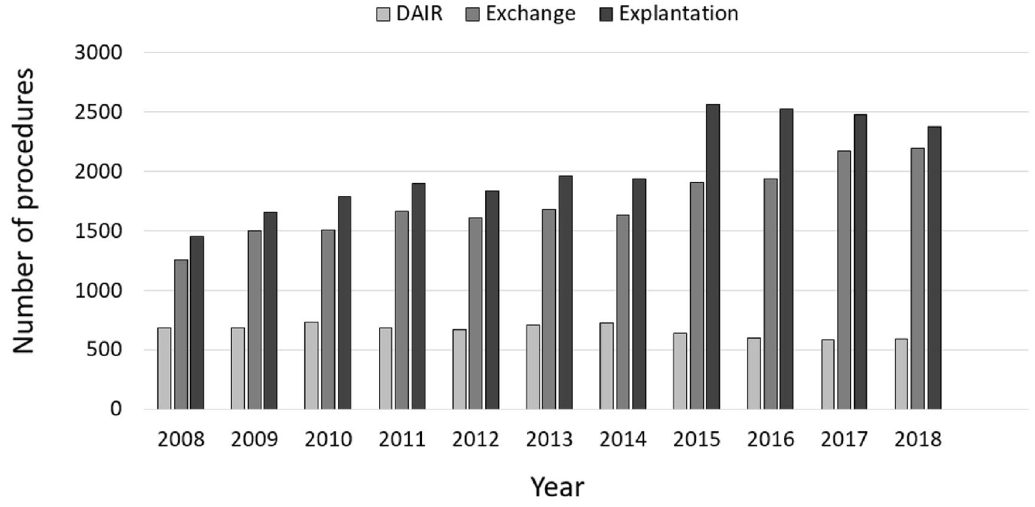
Figure 6. Performed surgical procedures in septic revision